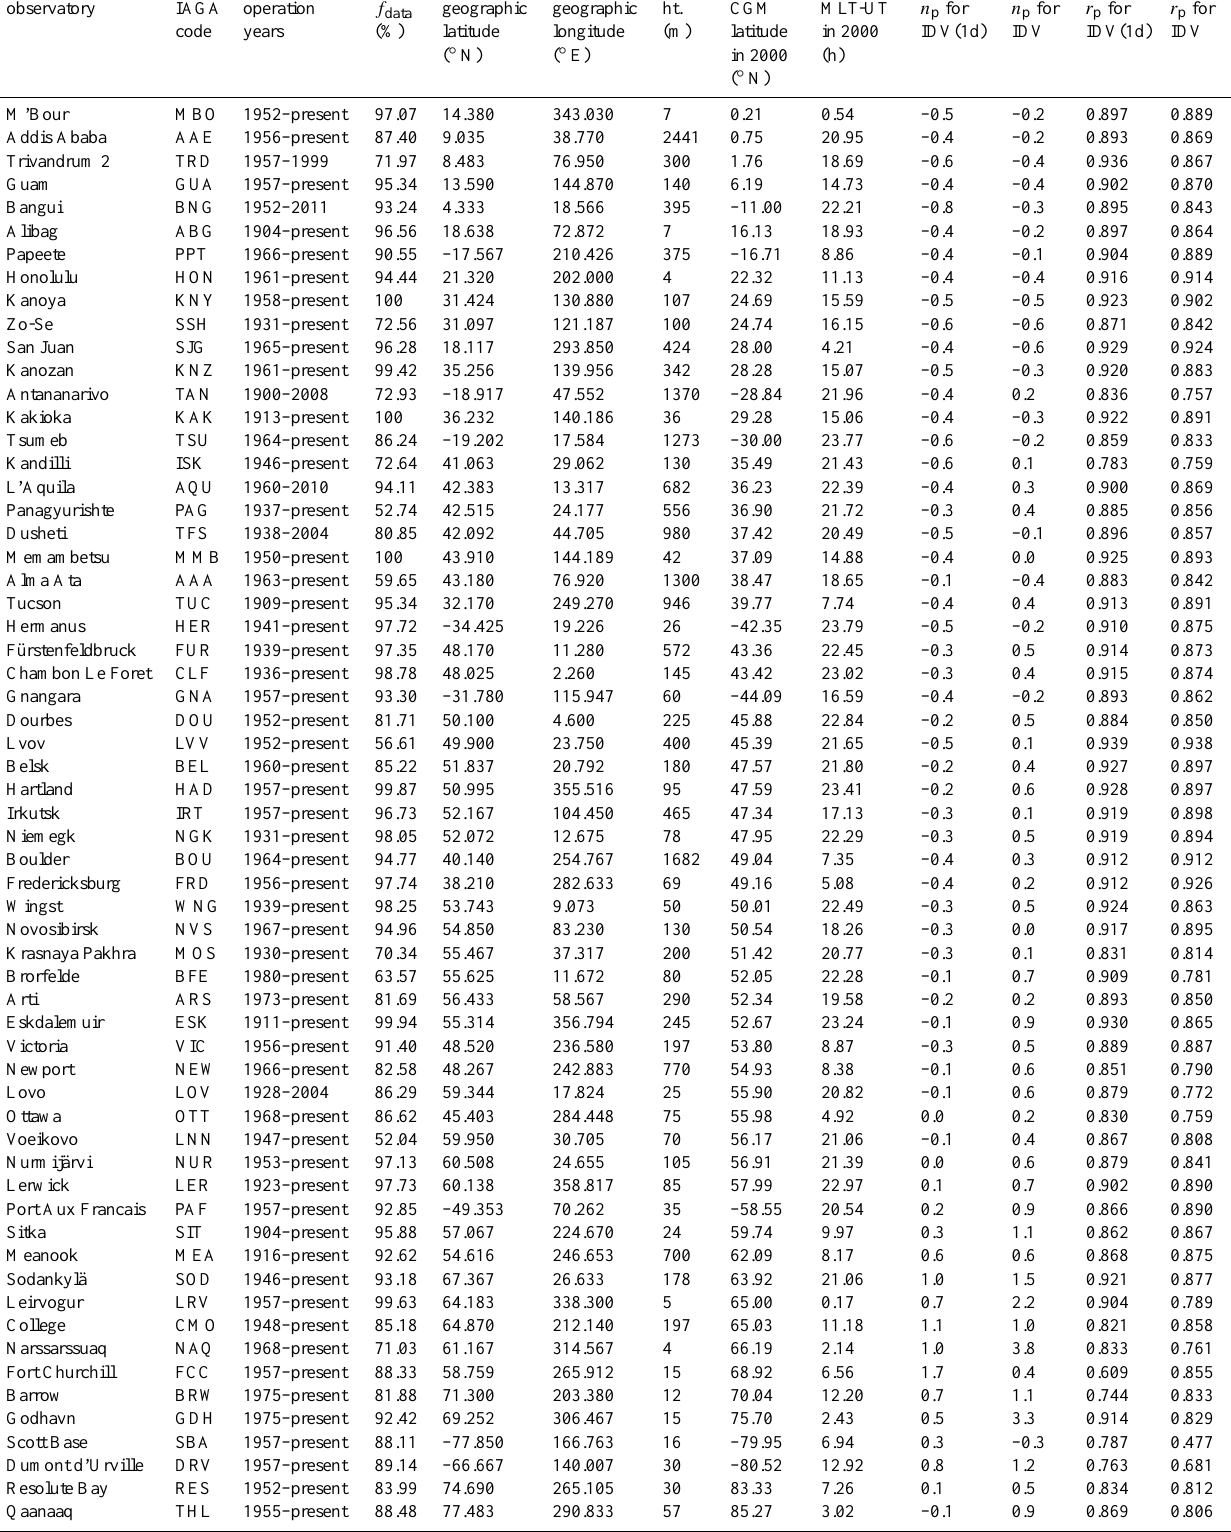
Table 2. Geomagnetic observatories compared to interplanetary conditions in this